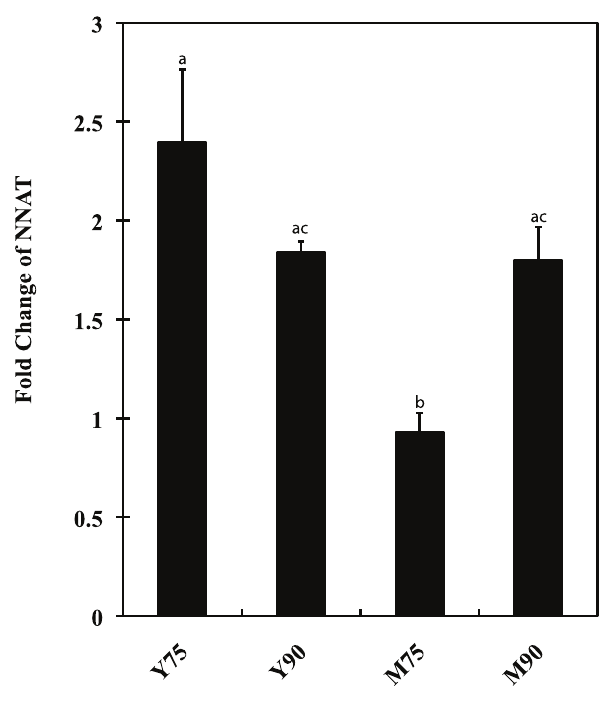
Figure 6. qPCR was used to investigate the mRNA profile of NNAT in Yorkshire and Meishan porcine placentas on day75 of gestation (Y75 and M75) and 90 (Y90 and M90). NNAT was significantly lower expressed in M75 compared with M90 and Y75 by SAS Anova test. The different superscript alphanumeric characters indicated a statistically significant difference at p , 0.05.